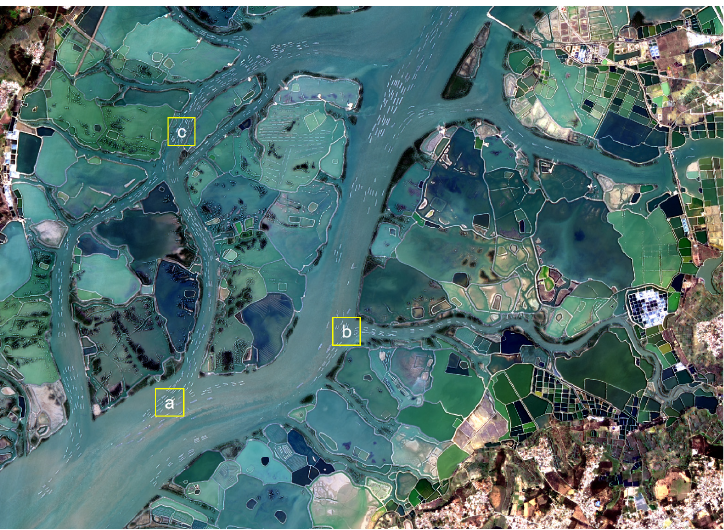
Figure 3. The research area, where a, b, c denotes three regions of study areas and the white color represents the aquaculture rafts.